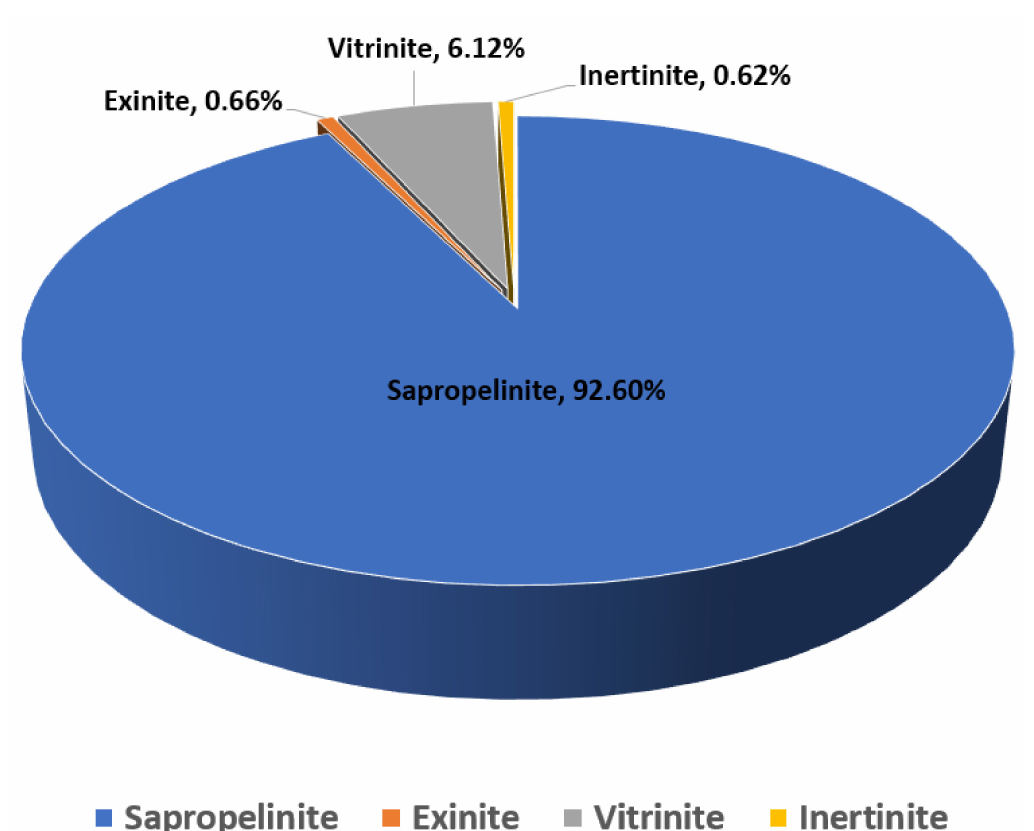
Figure 5. Relative ratio of kerogen maceral of lower Cambrian Niutitang formation black shale in Wenshuicun section, Guizhou